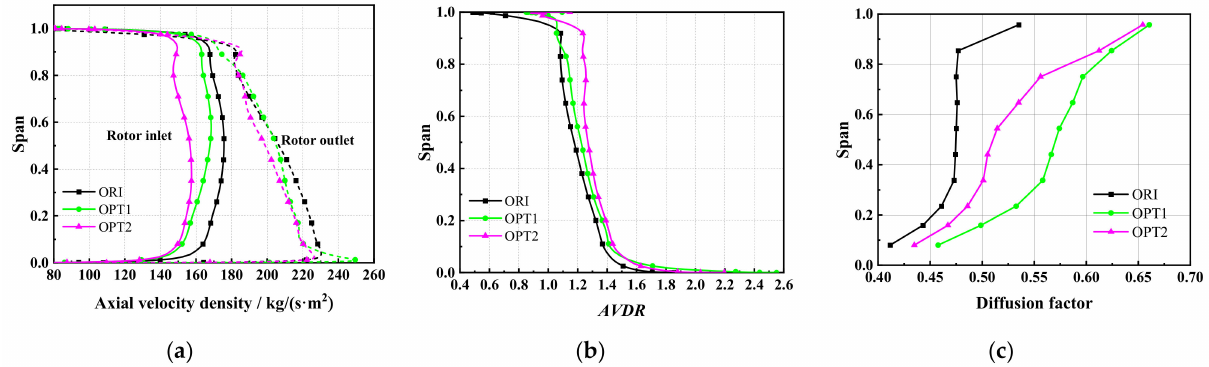
Figure 14. Airfoil geometry and isentropic Mach number on 98% blade span: ( a ) isentropic Mach number distribution; ( b ) airfoil geometry and throat position.